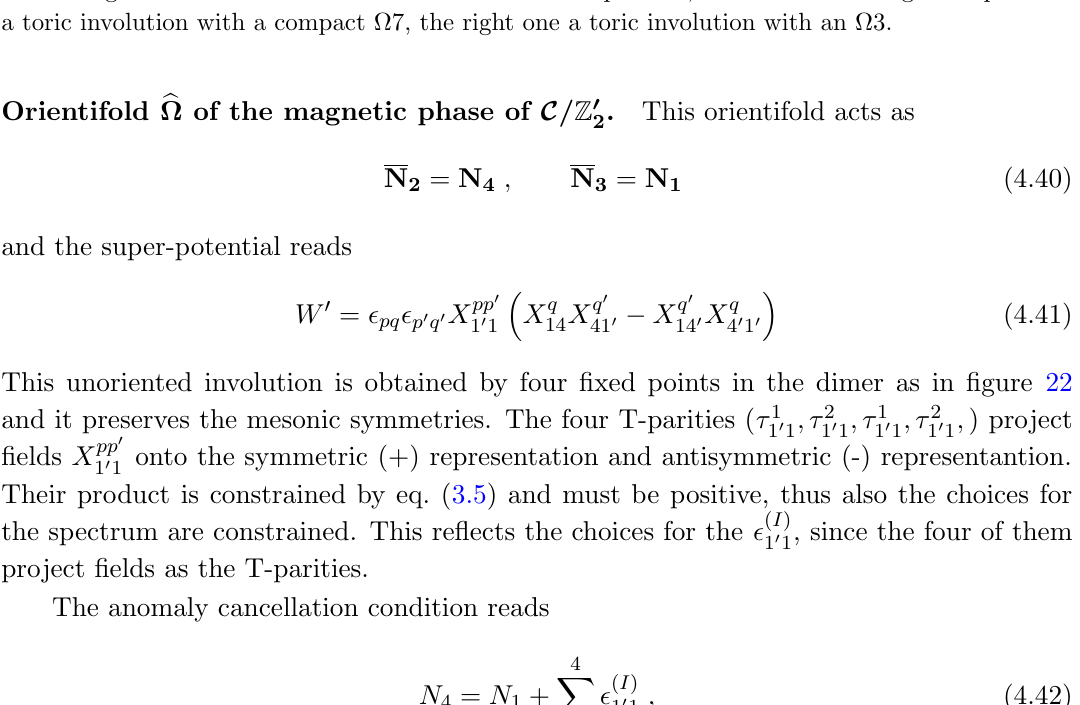
Figure 23. The various toric involutions b (cid:10) of the magnetic phase of C = Z 0 does not change the toric diagram, the possible involutions are the same as for the electric phase. The left (cid:12)gure shows the toric involution with a non-compact (cid:10)7, the center toric diagram represents a toric involution with a compact (cid:10)7, the right one a toric involution with an (cid:10)3.